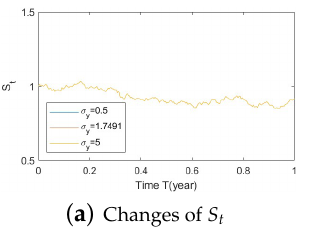
Figure A17. Illustrate the impact on ( a ) stock prices, ( b ) driver of elasticity, ( c ) elasticity of volatility, and ( d ) optimal stock allocations when varying θ y ( e . g ., θ y = − 5,2.7505,15 ) .